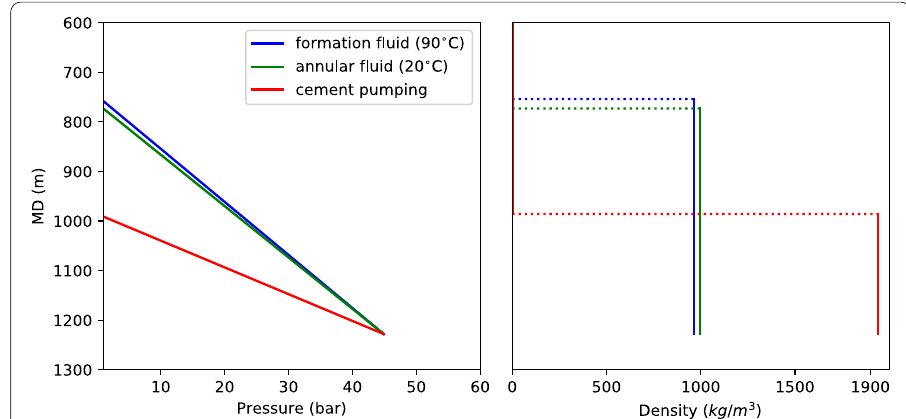
Fig. 8 Simplified representation of the pressure gradient in the well at different phases of the cementing